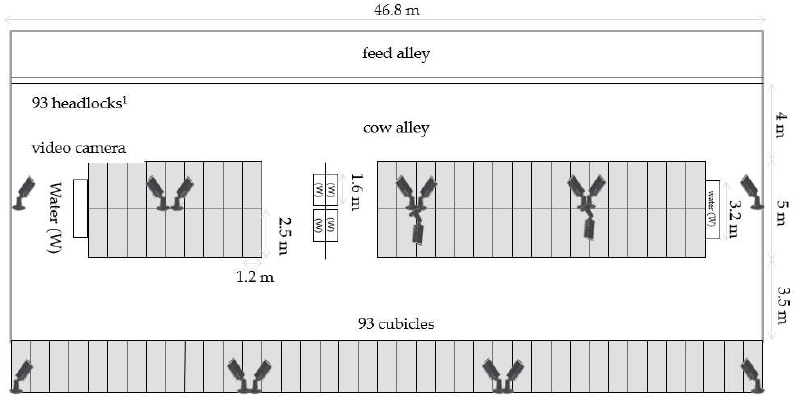
Figure 1. Stable plan: Illustration of the fresh cow pen with the feed alley, cubicles, and the position of the digital observation cameras. 1 Twist & Lock headlocks (GEA Farm Technologies GmbH, Bönen, Germany), m, meter.